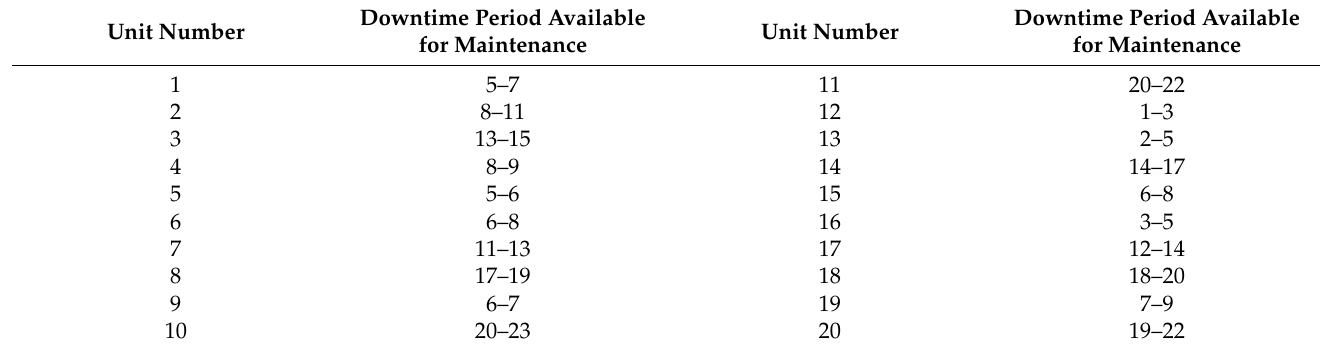
Table 3. The maintenance schedule of each unit in the actual power grid in Southwest